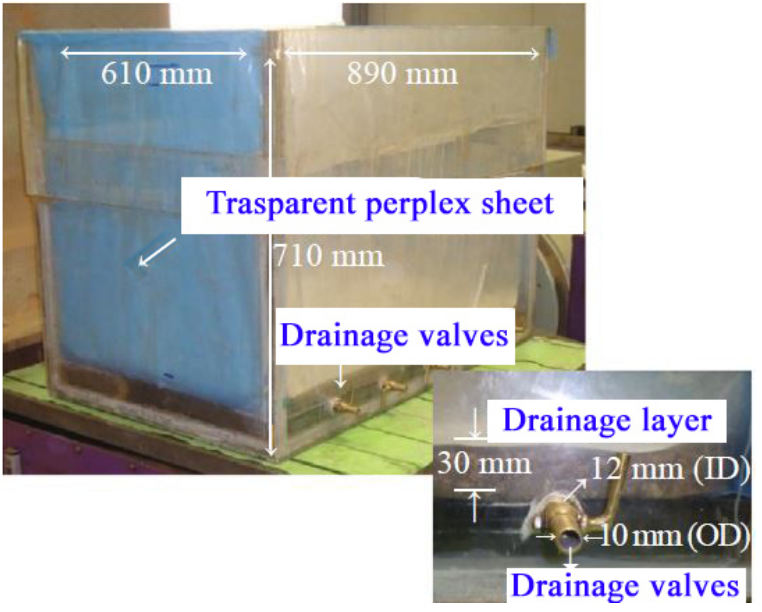
Figure 3. Rigid box with absorbent boundaries (From [42]; modified).